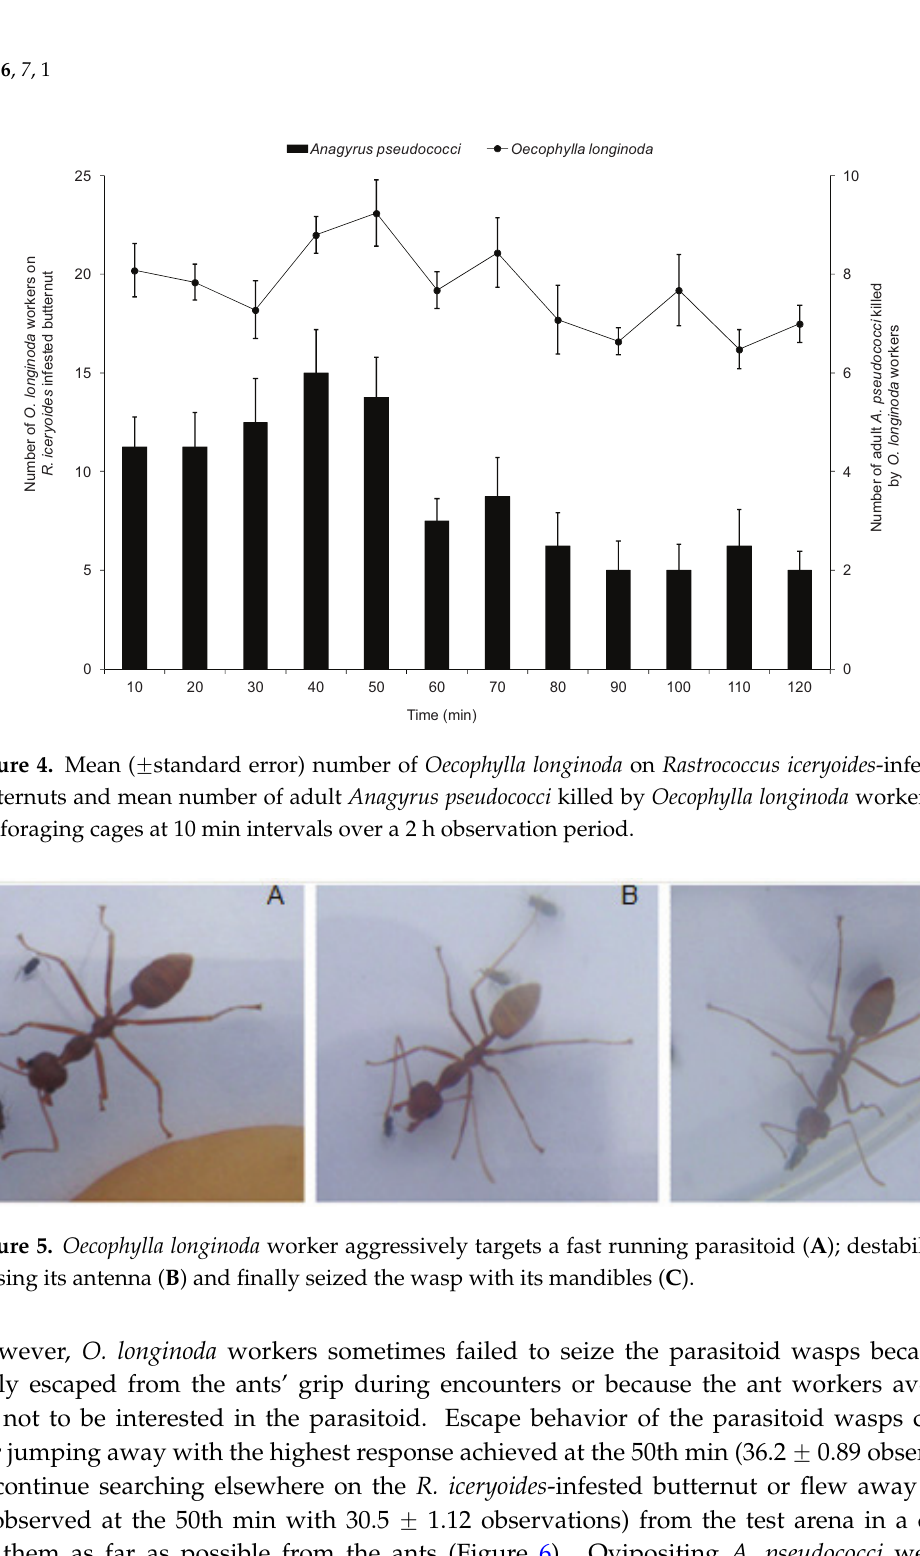
Figure 5. Oecophylla longinoda worker aggressively targets a fast running parasitoid ( A ); destabilizes it using its antenna ( B ) and finally seized the wasp with its mandibles ( C ).